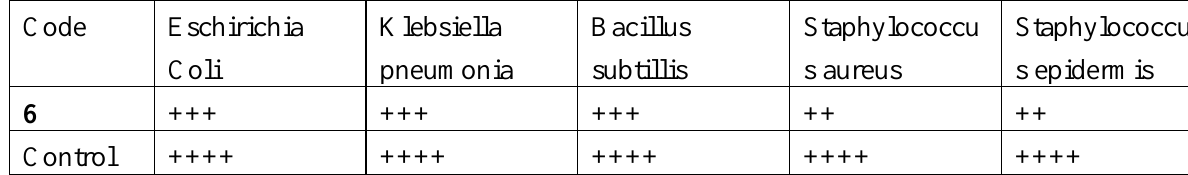
Table 1. Antibacterial activity of compound 6 against Gram positive and Gram negative bacteria, using Amikacin as